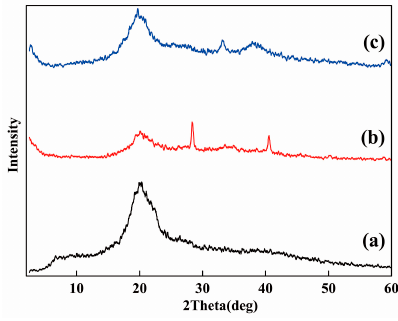
Figure 3. Powder X-ray diffraction diagrams of ( a ) OCMCS; ( b ) OCMCS-Pd; and ( c ) OCMCS-Ni.